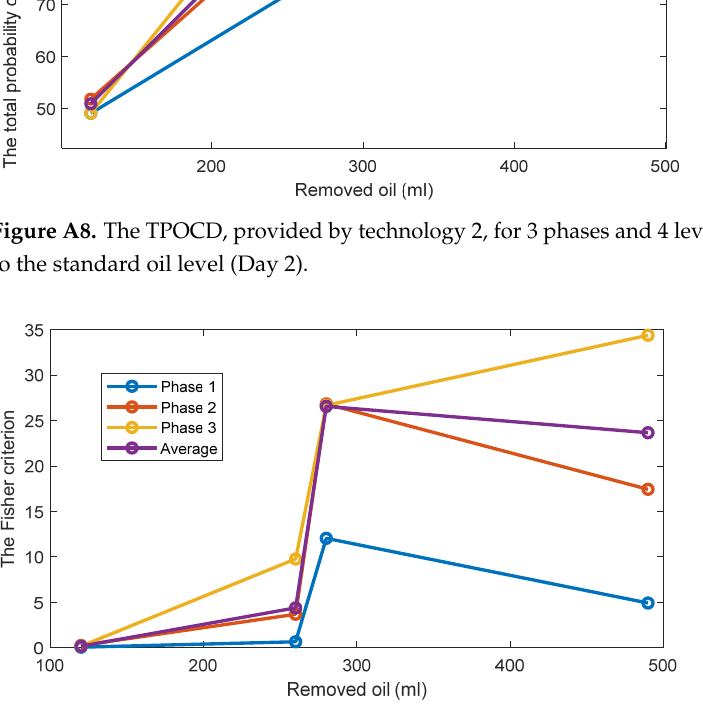
Figure A9. The FC of Feature 2 for 3 phases and 4 levels of oil removal compared to the standard oil level (Day 2).